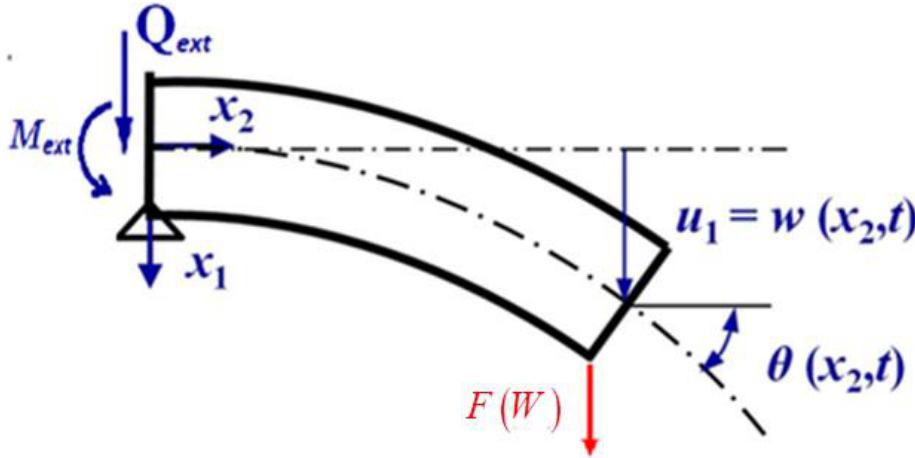
Figure 3. The displacement and loading condition of the lower prong.